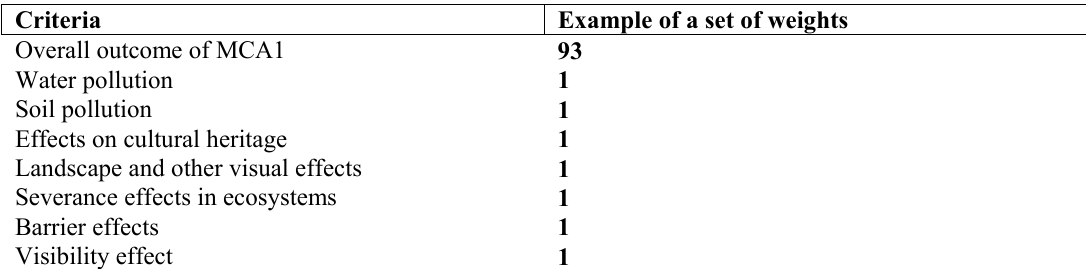
Table 5. Criteria in MCA2; example of a set of weights